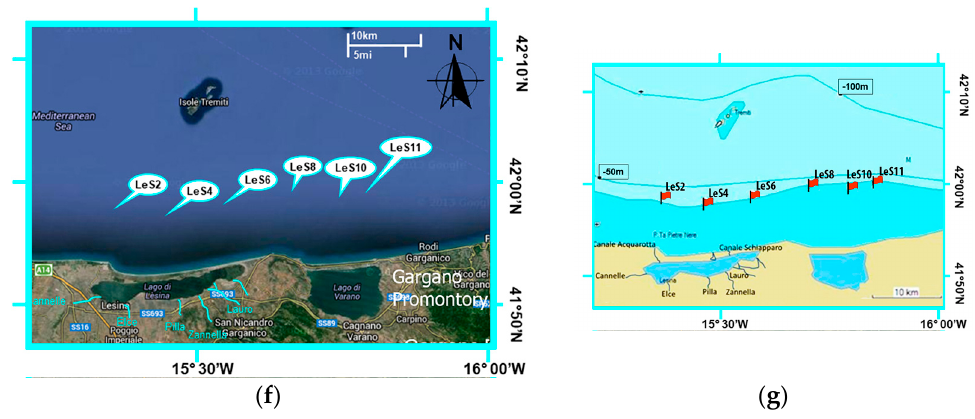
Figure 1. Study area: ( a ) study area locations (the red, green, and cyan shapes delimit coastal waters of the Manfredonia Gulf, Taranto Gulf, and the area close to Lesina Lagoon, respectively); ( b ) the measurement locations of coastal waters of the Manfredonia Gulf; ( c ) seafloor morphology of the Manfredonia Gulf; ( d ) measurement locations of coastal waters of the Taranto Gulf; ( e ) seafloor morphology of the Taranto Gulf; ( f ) measurement locations of coastal waters close to Lesina Lagoon; and ( g ) seafloor morphology of coastal waters close to Lesina Lagoon.